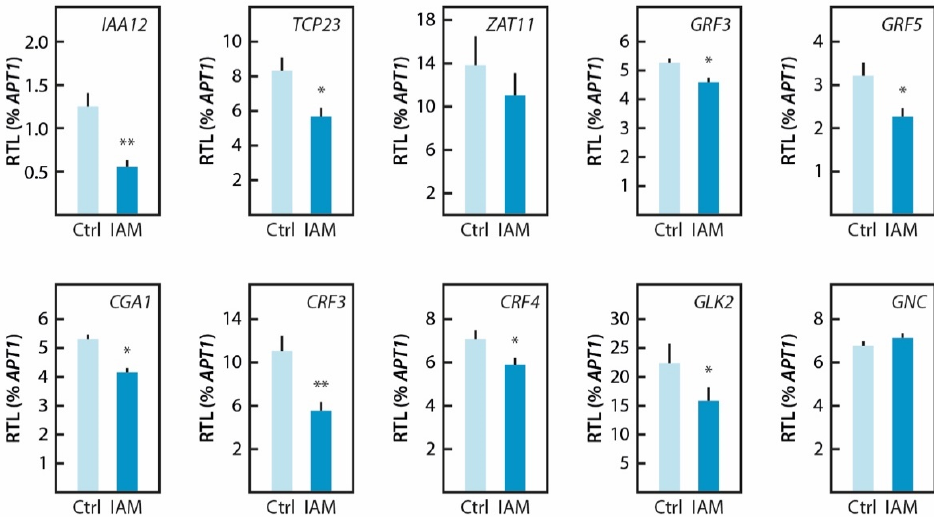
Figure 7. Validation of RNAseq data by qRT-PCR. The figure shows the relative transcript levels (RTL) of selected target genes (arithmetic mean ± SE, n = 9) normalized to APT1 as a constitutively expressed control gene in 7-day-old wt (Col-0) seedlings. Before RNA extraction, the seedlings were either treated for 2 h with 20 µM IAM (IAM) or with a control solution (Ctrl) free of IAM. The selected target genes were: IAA12/BDL , Aux/IAA protein 12 (At1g04550); TCP23 , TEOSINTE BRANCHED 1/CYCLOIDEA/PROLIFERATING CELL FACTOR 23 (At1g35560); ZAT11 , ZINC FINGER TRANSCRIPTION FACTOR 11 (At2g37430); GRF3 , GROWTH REGULATING FACTOR 3 (At2g36400); GRF5 , GROWTH REGULATING FACTOR 5 (At3g13960); CGA1 , CYTOKININ-RESPONSIVE GATA FACTOR 1 (At4g26150); CRF3, CYTOKININ RESPONSE FACTOR 3 (At5g53290); CRF4 , CYTOKININ RESPONSE FACTOR 4 (At4g27950); GLK2 , GOLDEN-LIKE 2 (At5g44190), and GNC , GATA, NITRATE-INDUCIBLE, CARBON-METABOLISM INVOLVED (At5g56860), in order of appearance. Asterisks indicate significant differences between the corresponding control sample and the IAM treated sample. (Student’s t -test; * p ≤ 0.05, ** p ≤ 0.01).